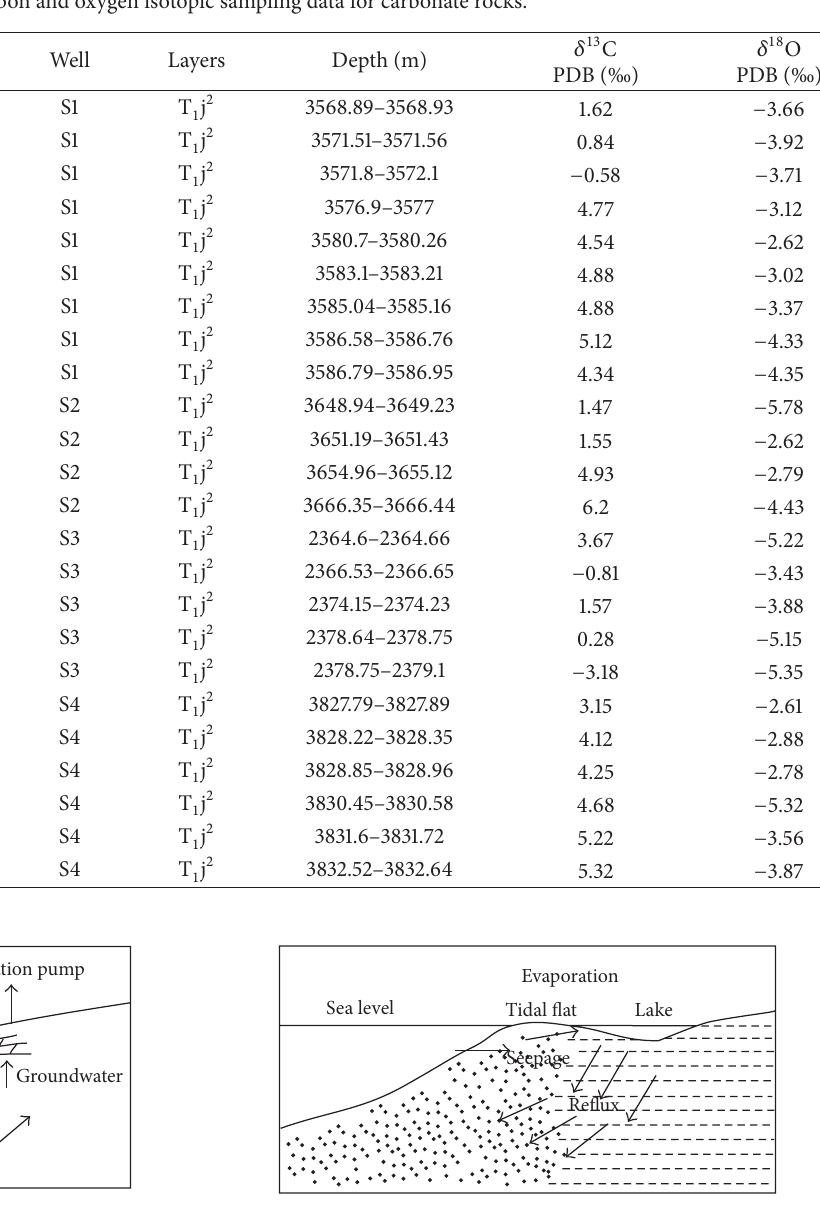
Figure 8: The mechanism of evaporation pump. Figure 9: The mechanism of seepage